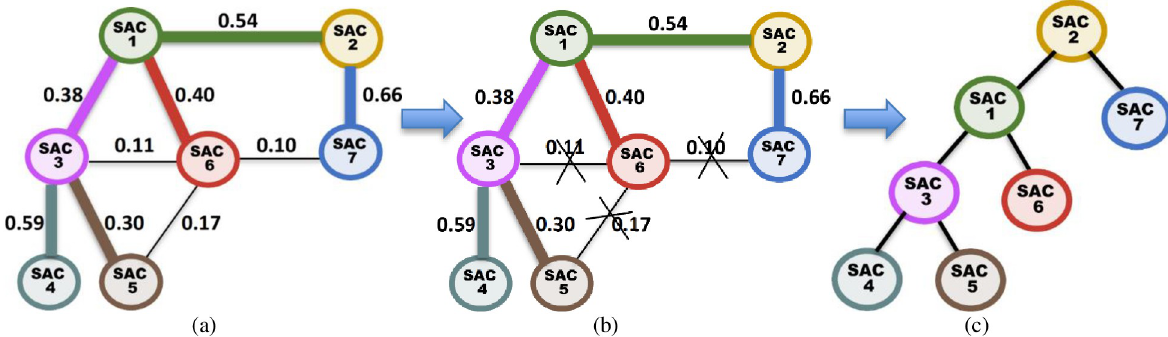
Fig 9. (a) The Association Edge with the highest GI score connected to each SAC node in the MRG (for easy reference, each node and the Association Edge with the highest GI score connected to it are marked with the same colour), (b) each Association Edge Ҿ that will be removed from the MRG because the two nodes at its end points are connected to other Association Edge, whose GI scores are higher than that of Ҿ , and (c) the resulting MKCSS Relationship